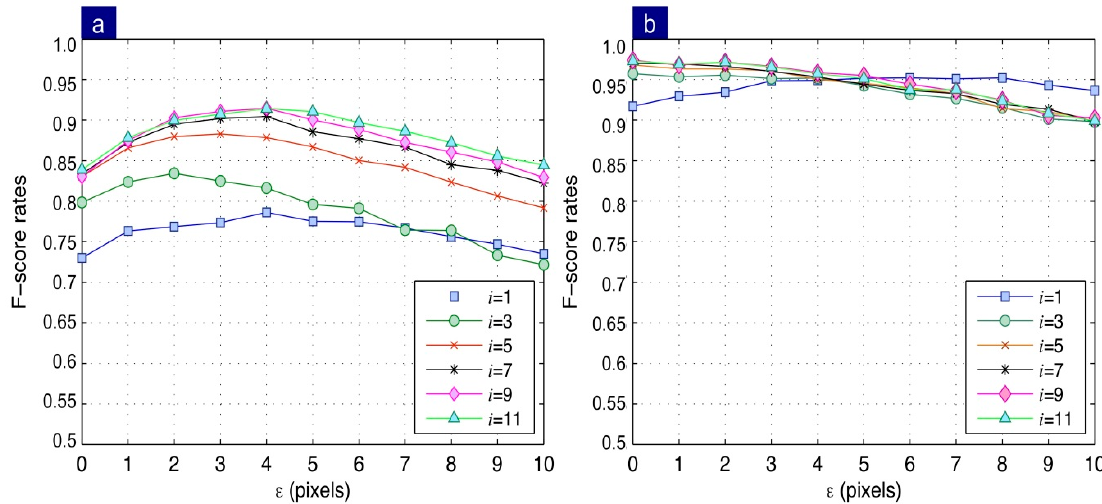
Figure 14. Influence of 𝜀 on performance for a different number of solutions i : ( a ) two and ( b ) three views.